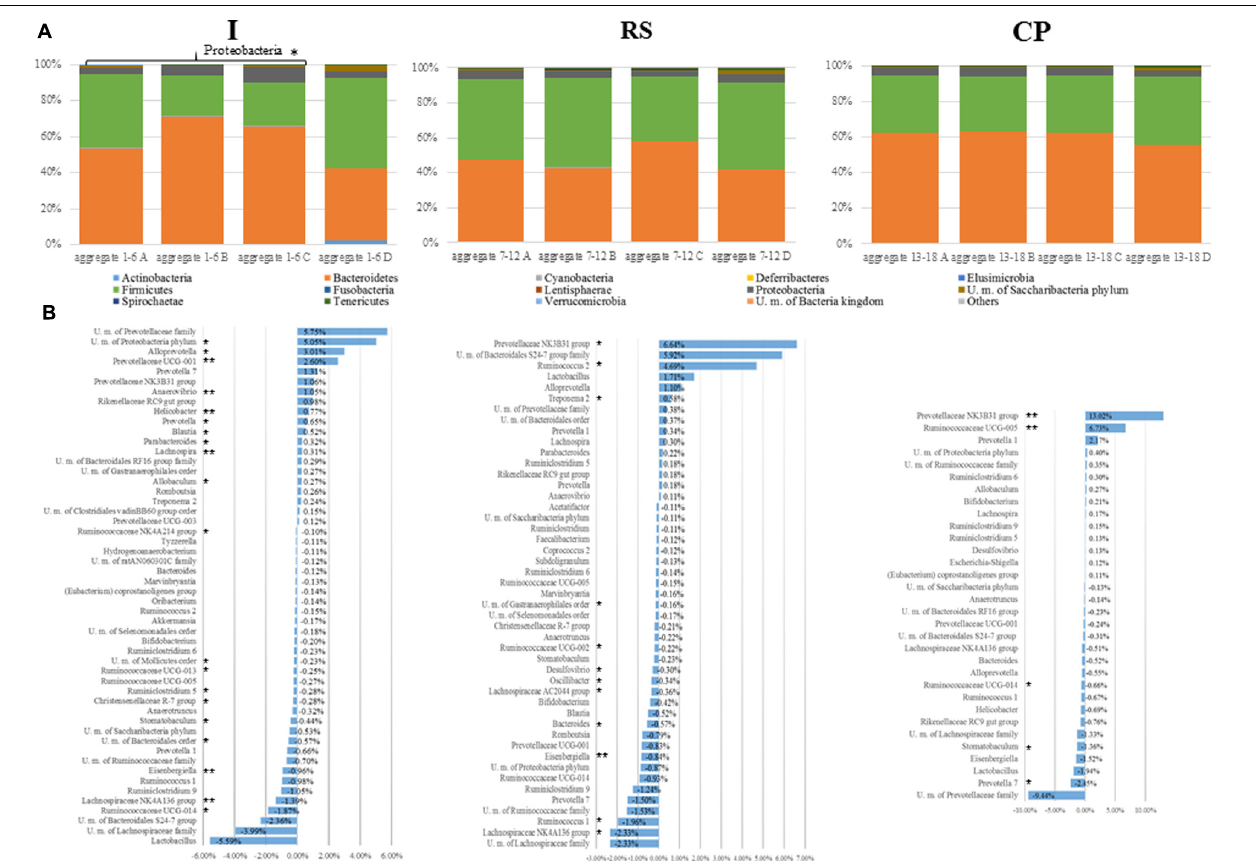
FIGURE 3 | Exploration of microbiota diversity associated with RS, I, and CP interventions at different time points. (A) Represents bar plots of the identified bacterial phyla in the 72 analyzed samples, 24 samples per substrate, six for each time point. The legend reports the average relative abundance of each phyla for each substrate tested. (B) Depicts the variation in terms of relative abundance > 0.1% and < –0.1% of the bacterial taxa, for the three substrates (respectively, I, RS, and CP) at the end of the prebiotic supplementation (T2) in comparison with the initial microbiota composition (T0). Statistical significance of microbial modulation has been calculated using Lefse (https://huttenhower.sph.harvard.edu/galaxy/) and indicated with asterisks as follow: ∗ p -value < 0.05, ∗∗ p -value < 0.005, and ∗∗∗ p -value <